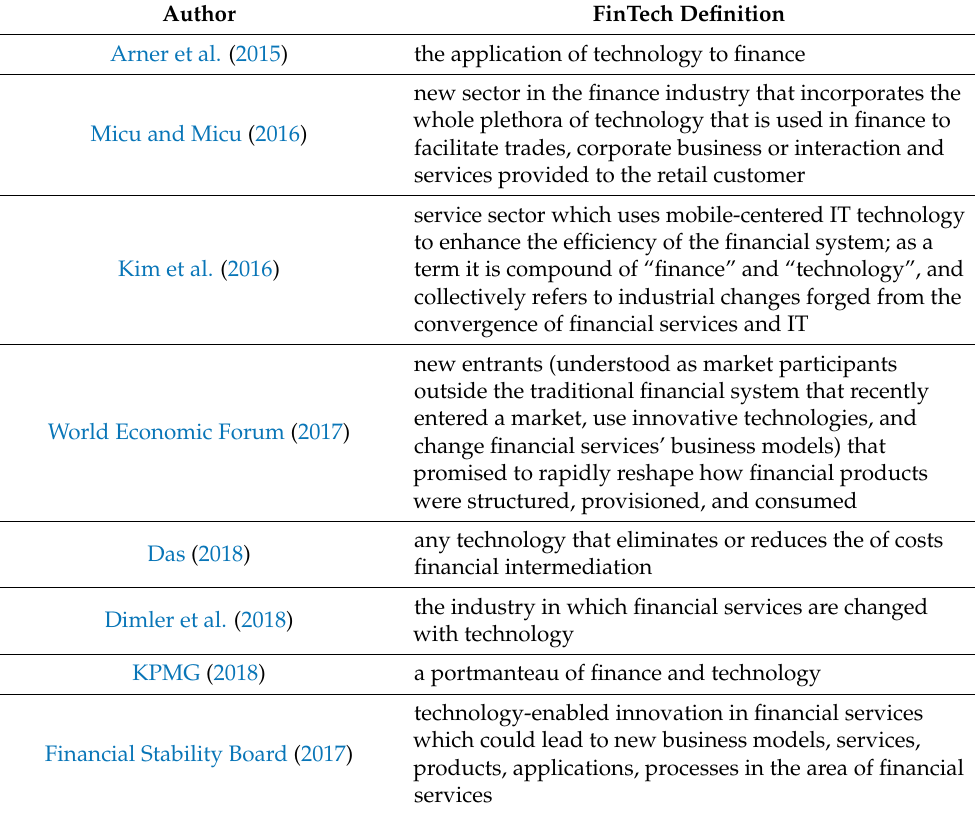
Table 1. The selected definitions of